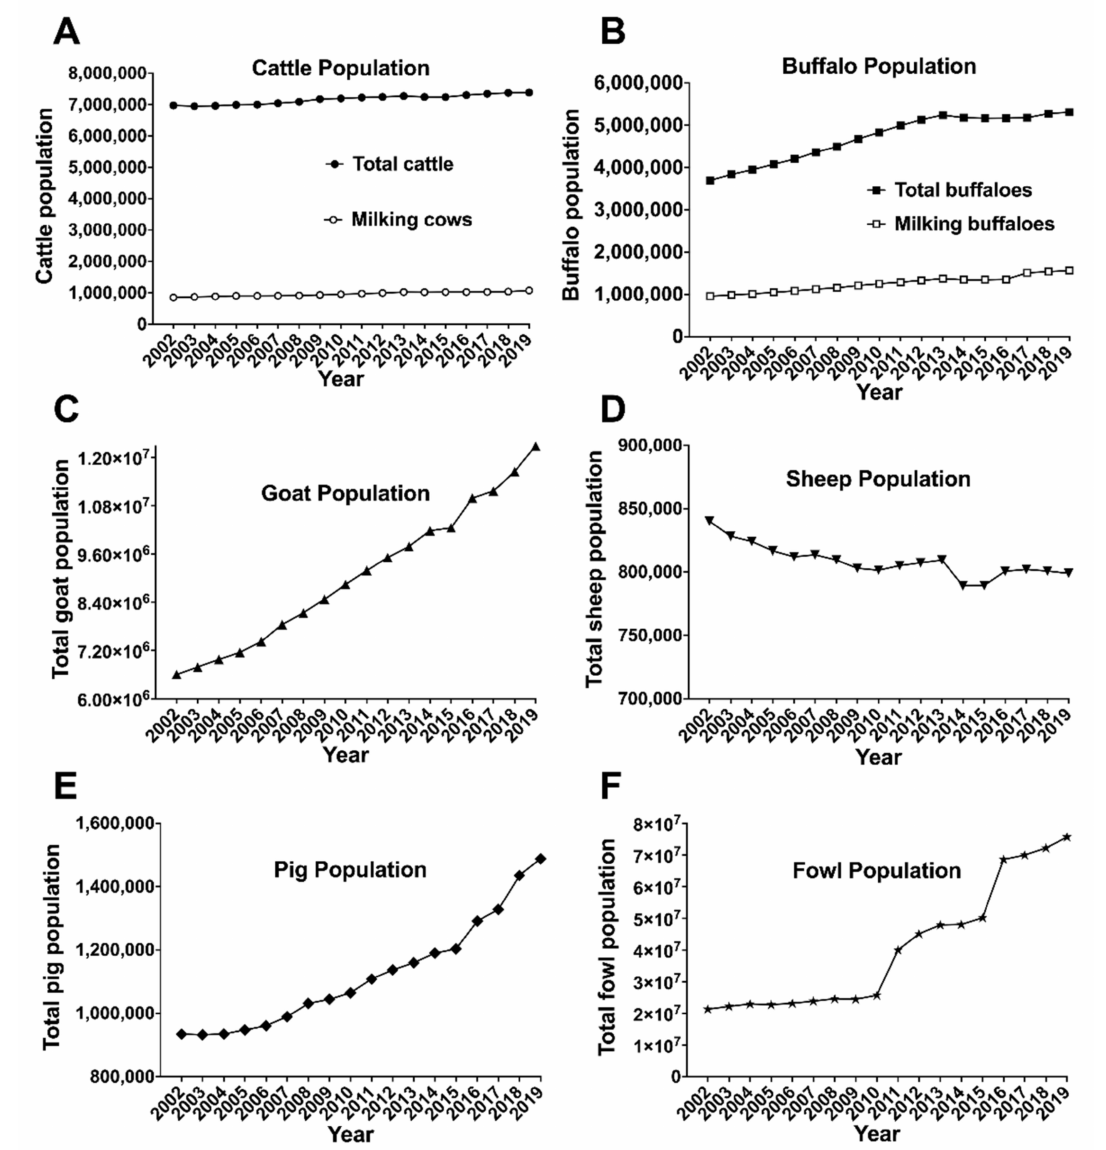
Figure 1. Population trend of major livestock species in Nepal from 2002 to 2019 (MOALD, 2017; MOALD, 2019) [15,16]. ( A ): Population trend of cattle (solid line, : number of milking cows), ( B ): Population trend of buffalo (solid line, (cid:4) : total number of buffalo; (cid:35) solid line, (cid:3) : number of milking buffalo), ( C ): Population trend of goats, ( D ): Population trend of sheep, ( E ): Population trend of pigs, and ( F ): Population trend of